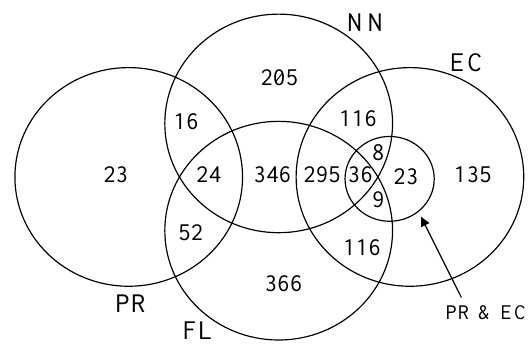
Fig. 4. Number of articles according to mentioned tech-